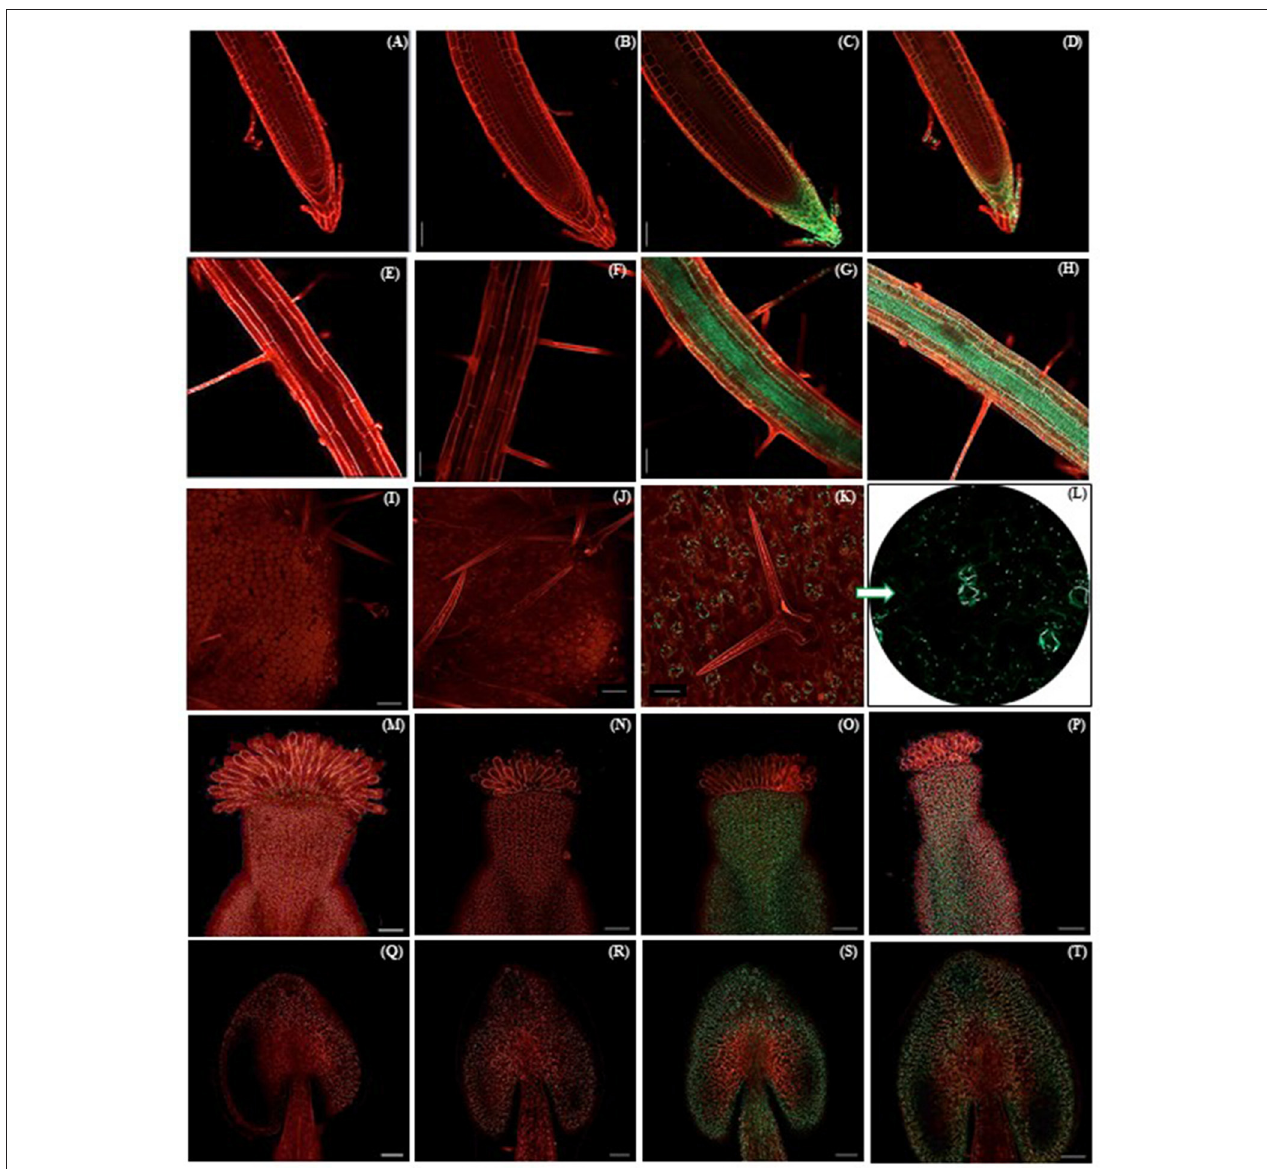
FIGURE 4 | GFP fluorescence emission under UV light in different organs of transgenic Arabidopsis thaliana plants expressing the N-terminal eGFP :: AhN4L-1 fusion gene. GFP emission against a background of propidium iodide stained tissues, was detected in the root tips (C,D) , root vasculature and root hairs (G,H) , stomata on the adaxial leaf surface (K,L) , the base of the flower pistil (O,P) and the anthers (S,T) . Images of propidium iodide stained root tips (A,B) , root vasculature (E,F) , the adaxial surface of leaves (I,J) , pistils (M , N ) and stamens (Q,R) of untransformed WT controls are shown. Bars = 0.05mm in all